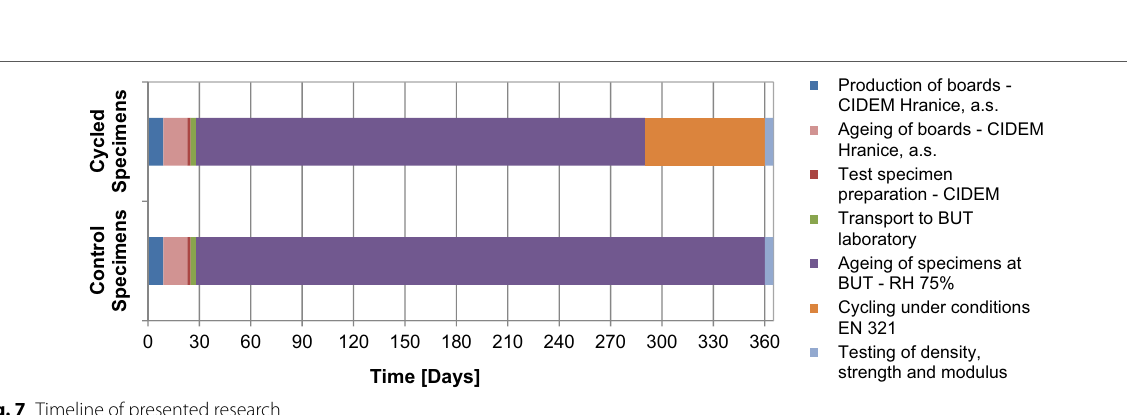
Fig. 6 Detail of chips separated from crushed cuttings of cement-bonded particleboards (images from electron microscope): a 0.5 mm to 1.0 mm; b 1.0 tot 2.0 mm